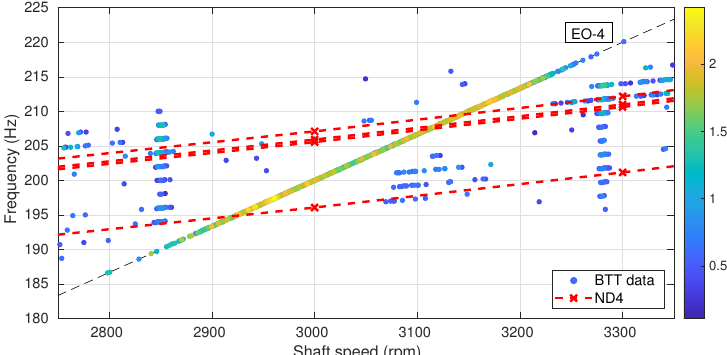
Figure 10. Blade displacement from BTT for the mistuned configuration [0001] with an EO4 excitation. The vibration amplitude of the lower-frequency resonance peak (mistuned blades) appears again to be higher than that of the higher-frequency peak (tuned blades). This is more clearly seen in Figure 11, where the measured displacement of the first 4 blades is plotted together with the averaged displacement of all 4 types of blades present in the rotor. The mistuned blade (blade #4) presents a response made of a single peak at the lower frequency and with a quite large amplitude. The 2 adjacent blades in one direction (blade #3 and #2) have mainly a single peak, in this case at the higher frequency, with a slightly lower amplitude. Additionally, finally, the blade adjacent in the other direction (blade #1) has a main peak at the lower frequency but smaller in amplitude than the peak of the mistuned blade (blade #4).